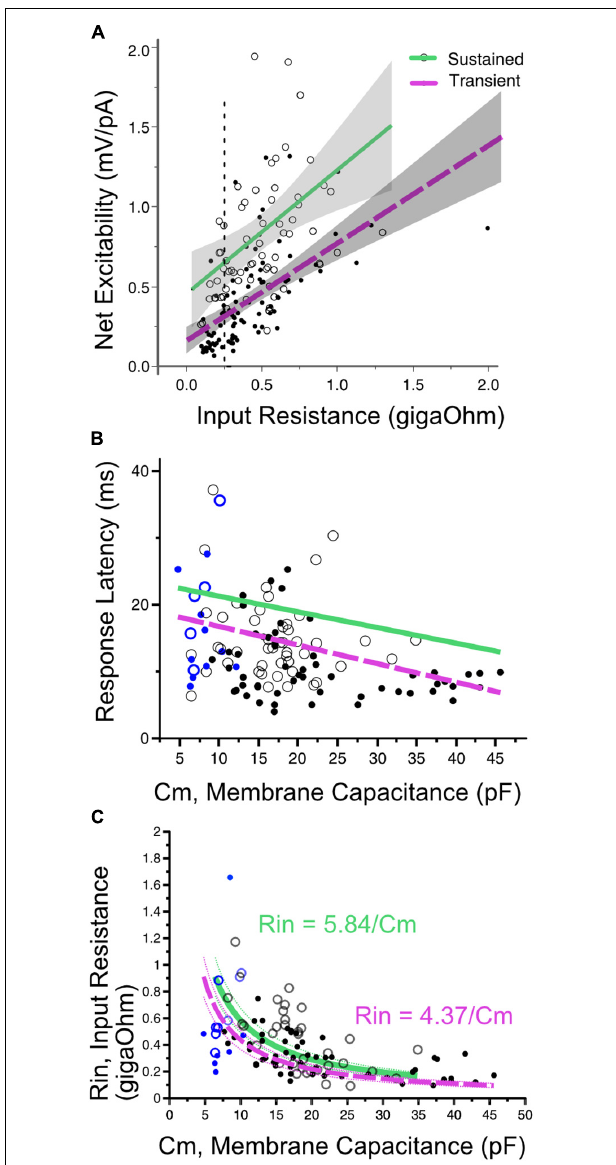
FIGURE 6 | (A) Net excitability vs. input resistance for transient- (solid dots) and sustained-spiking neurons (open circles) in VGN and SGN pooled. Regression lines plus 95% confidence intervals are drawn through each firing pattern group. Sustained and transient-spiking neurons with magenta and green lines, respectively. Cells with similar input resistance (e.g., 0.25 gOhms, dotted verticle line) differ in net-excitability, with sustained-spiking neurons being more excitable than transient-spiking neurons. (B) Indicative of covariance between input resistance and cell size, first-spike latency decreases with increasing membrane capacitance. Solid magenta and dashed green lines show linear regressions through sustained- and transient-spiking cells. VGN and SGN data are distinguished by black and blue symbols, respectively. Symbols defined as in A. ANCOVA effect tests comparing regressions are shown in Table 1 . (C) Input resistance decreases with membrane capacitance ( C m ). The data are fit with two functions in the form R in = A / C m . A is equivalent to the specific membrane resistance and is larger for sustained-spiking neurons than for transient spiking neurons. The relationship between R in and C m is consistent with the idea that the number of